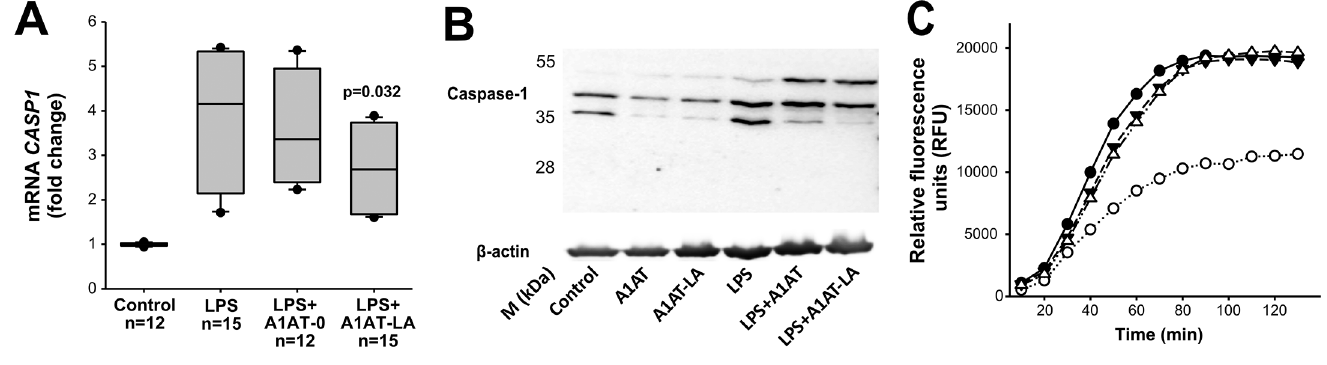
Figure 5. Effect of A1AT-0 and A1AT-LA on LPS-induced caspase-1 expression and activity. Human neutrophils (5 × 10 6 ) were incubated for 5 h in either medium alone or medium containing LPS (20 ng/mL) in the absence or presence of A1AT-0 (1 mg/mL) or A1AT-LA (1 mg/mL). mRNA expression of the CASP1 gene (A) was analyzed by real-time qPCR as described in Materials and Methods. GAPDH and HPRT were used as housekeeping genes. Box plots represent data from 4 individual experiments; n = number of replicates for each experiment. P value indicates significant differences compared with the values seen in LPS-activated cells. Total cell lysates were ana- lyzed for the caspase-1 protein profile characterization by western blotting (B). For loading control, blots were reprobed with antibodies to β -actin. The blot is representative of 3 independent donors with similar results. Caspase-1 activity (C) was analyzed in vitro by using caspase-1 fluorogenic tetrapeptide substrate (YVAD-AFC). Data represents caspase activity (in relative fluorescence units) in the pres- ence of either 1 mg/mL A1AT-0 or A1AT-LA or 20 μ M z-VAD-FMK (generic caspase inhibitor). Measurements were taken every 10 min. Each curve represents data from 2 independent experiments, each performed in triplicate.